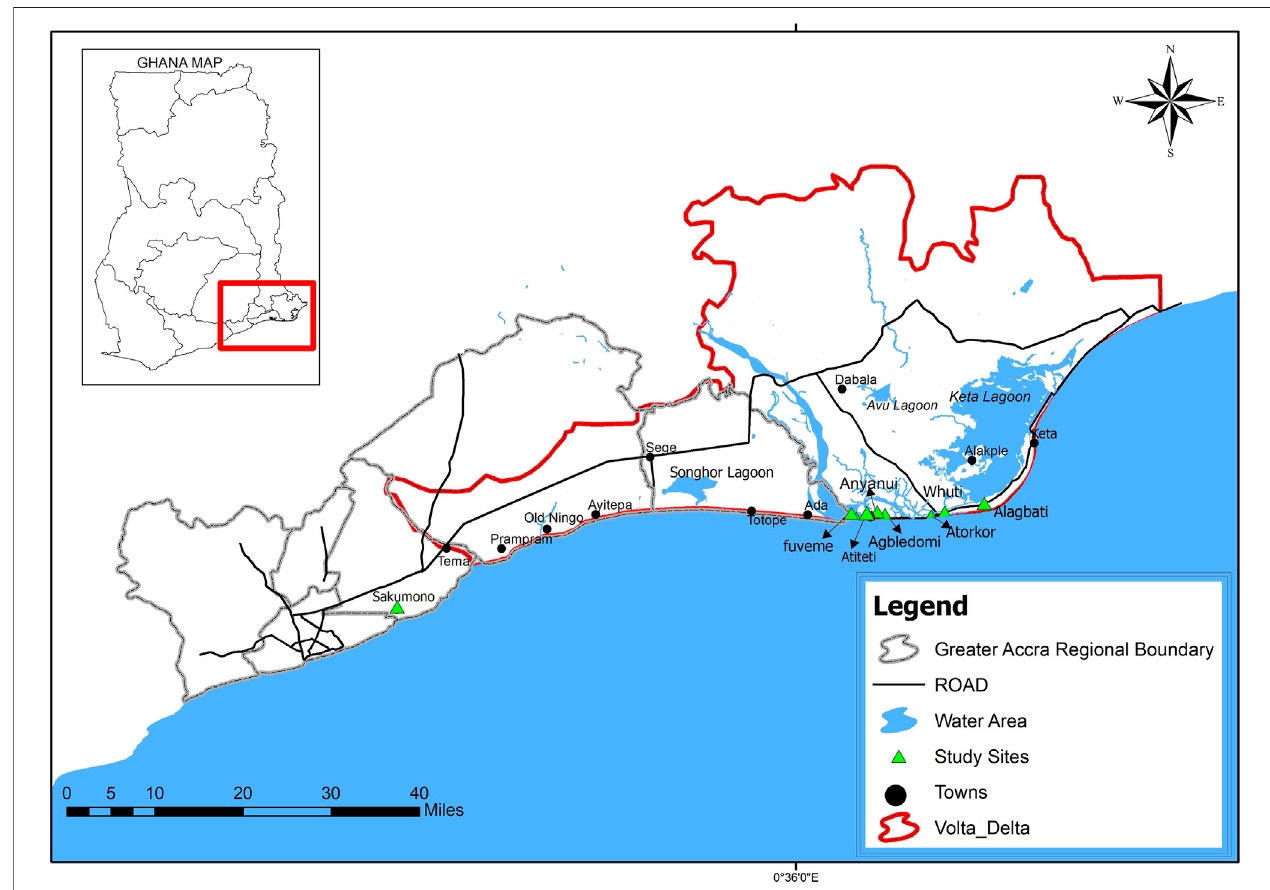
FIGURE 1 | Map with the locations of the study